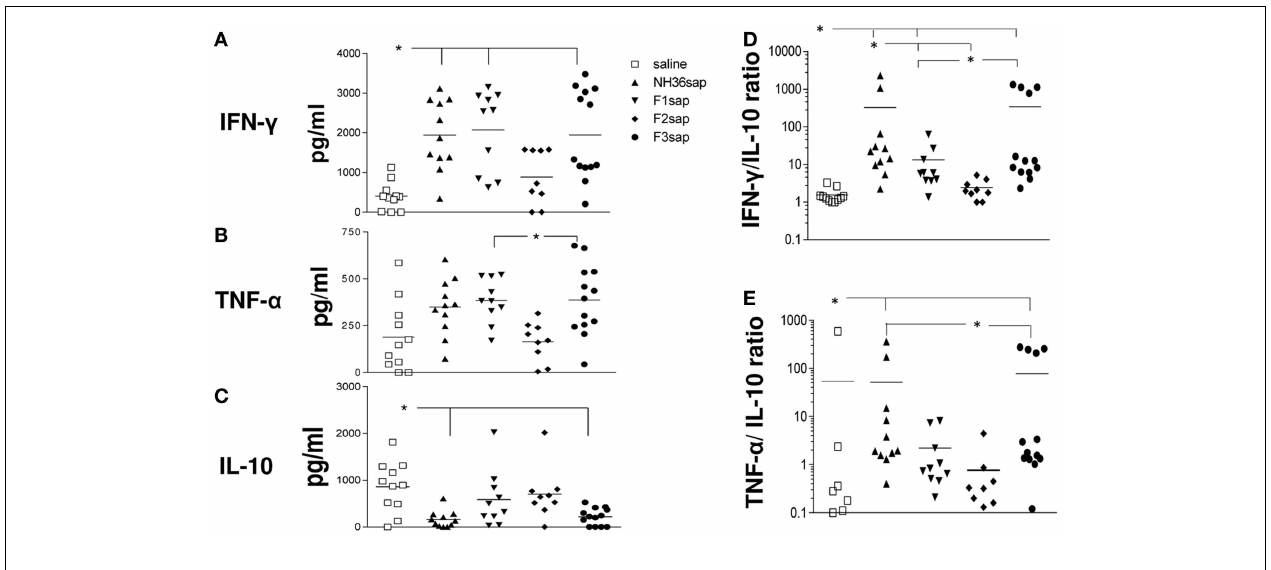
secreted cytokines, expressed as picogram per milliliter, of two independent experiments (six to seven mice per treatment in each experiment) and as the IFN- γ /IL-10 (D) andTNF- α /IL-10 (E) ratios. *Significant differences between treatments.